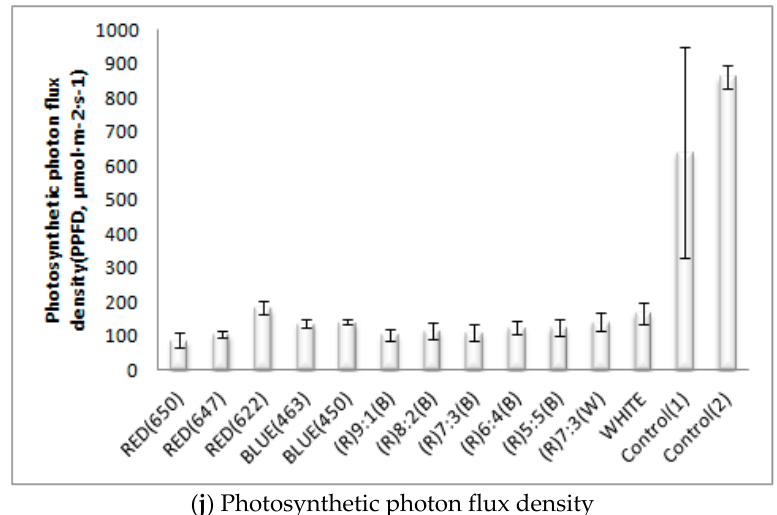
Figure 17. Growth pattern of lettuce in the plant factory. Meanwhile, the Kruskal – Wallis test was conducted to examine the significance of the normal distribution patterns in the growth of lettuce, which shows constant trends under various light sources. The analysis data, for which the null hypothesis was not rejected, are shown in Figure 18.